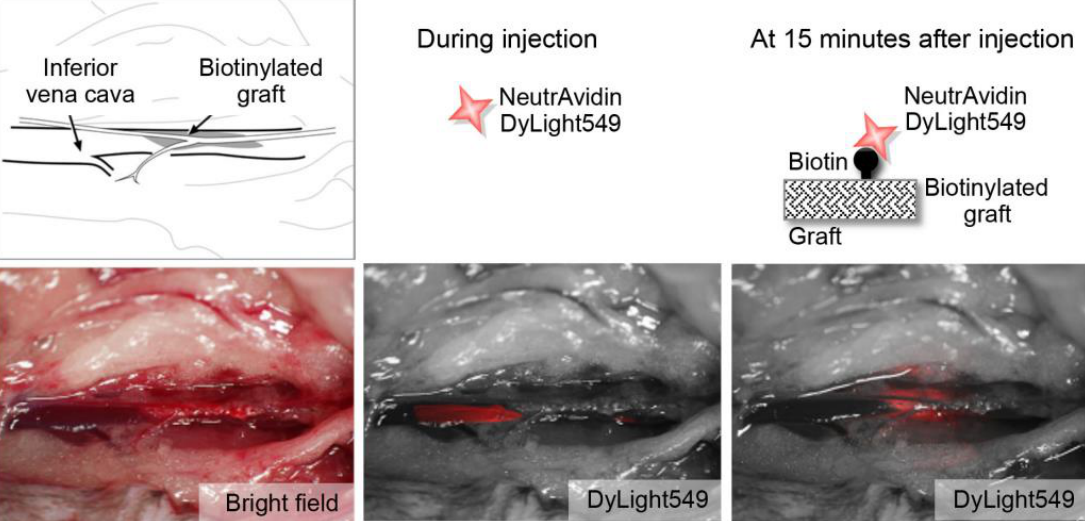
Figure 3. Feasibility of using the targeted graft in mouse blood vessels. (Upper panels) Schematic diagrams show the main features of the procedure. (Lower, left) Bright field image shows the placement of the biotinylated graft in the mouse inferior vena cava. (Lower, middle) Fluorescence image acquired just after injection shows the passage of DyLight549-labeled neutravidin (red) through the inferior vena cava. (Lower, right) Fluorescence image acquired at 15 min after injection shows the accumulation of DyLight549-labeled neutravidin at the biotinylated graft.